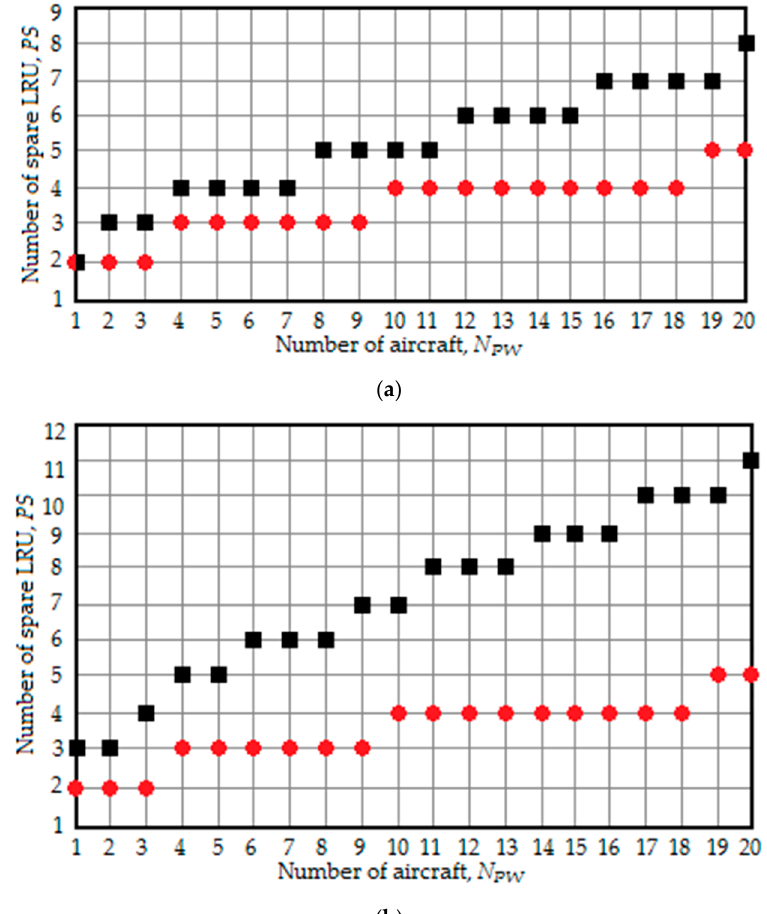
Figure 11. The dependency of the optimal quantity of spare LRU on the quantity of aircraft for the first PWM option; ( a ) 𝜃 = 1 × 10 (cid:2879)(cid:2872) h (cid:2879)(cid:2869) , red circles: 𝑃 (cid:3033)(cid:3039)(cid:3036)(cid:3034)(cid:3035)(cid:3047)(cid:3007)(cid:3017) = 1 × 10 (cid:2879)(cid:2872) , black squares: 𝑃 (cid:3033)(cid:3039)(cid:3036)(cid:3034)(cid:3035)(cid:3047)(cid:3007)(cid:3017) = 1 × 10 (cid:2879)(cid:2871) ; ( b ) 𝑃 (cid:3033)(cid:3039)(cid:3036)(cid:3034)(cid:3035)(cid:3047)(cid:3007)(cid:3017) = 1 × 10 (cid:2879)(cid:2872) , red circles: 𝜃 = 1 × 10 (cid:2879)(cid:2872) h (cid:2879)(cid:2869) , black squares: 𝜃 = 1 × 10 (cid:2879)(cid:2871) h (cid:2879)(cid:2869) .